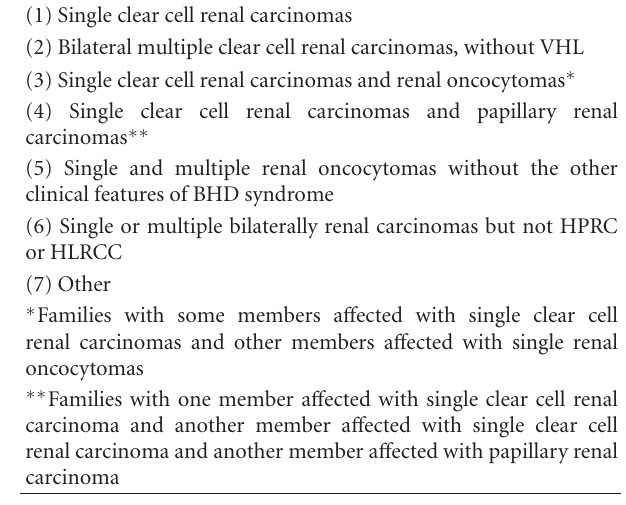
Table 3: Clinical and pathological subtypes of familial renal carcinoma (adapted from Zbar et al.